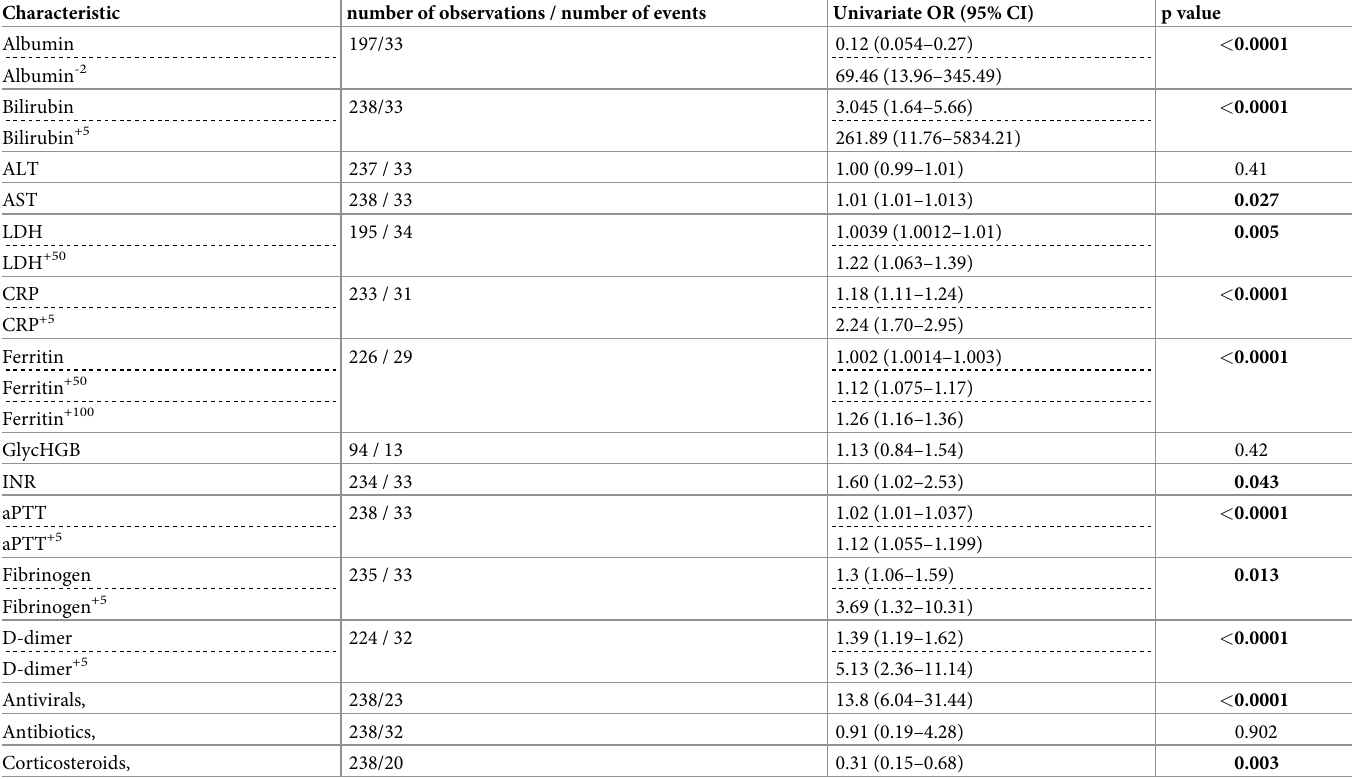
Lymphocyte Ratio; WBC, white blood cell count; PLT, platelet count; RBC, Red blood cell count; HGB, Hemoglobin; ALT, Alanine aminotransferase; AST, Aspartate aminotransferase; LDH, Lactate dehydrogenase; CRP, C-reactive protein; GlycHGB, glycosylated hemoglobin; INR, International normalized ratio; aPTT, activated partial thromboplastin time.